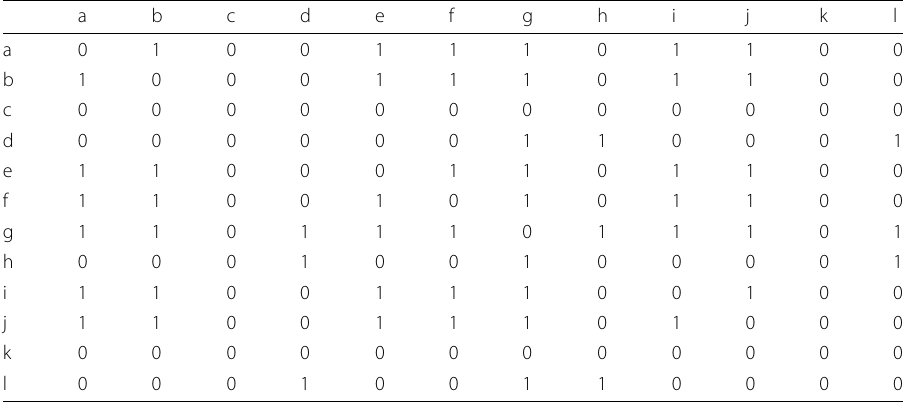
Table 2 Adjacency matrix